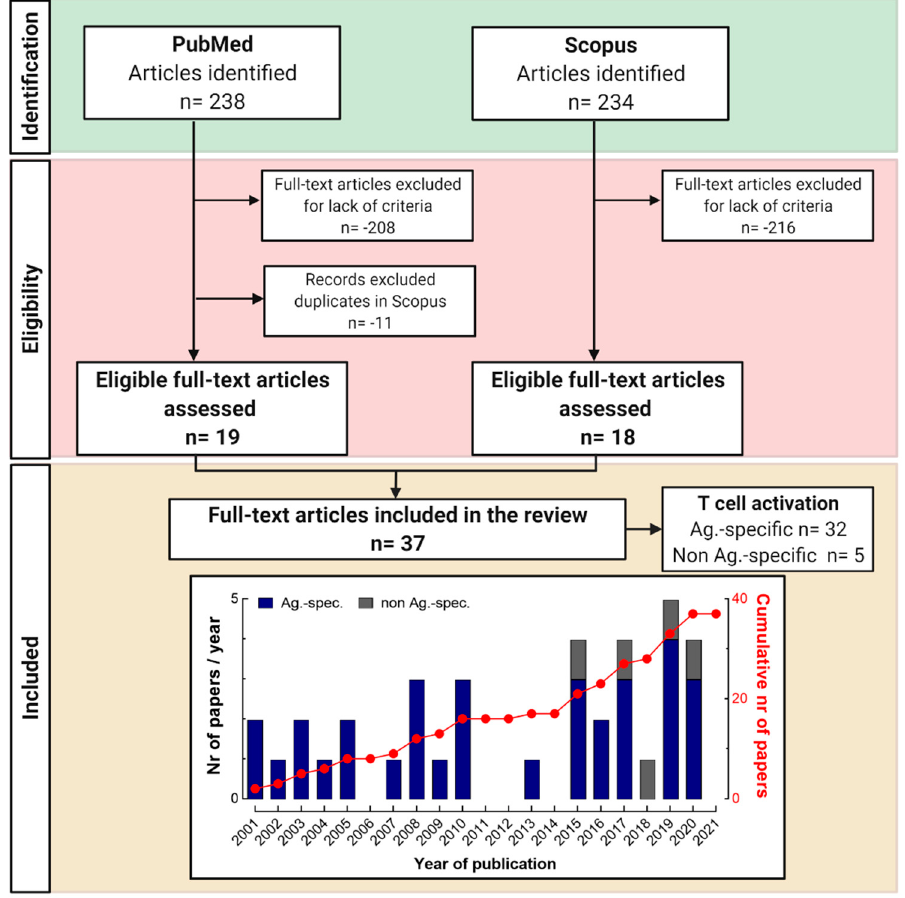
Figure 2. Flowchart of the search strategy applied in this systematic review according to the PRISMA statement 2020 guidelines [87]. The stacked bar histogram represents the time distribution of the articles included by year of publication (antigen (Ag.)-specific, blue, vs. non Ag.-specific, grey) and the red line the cumulative number of papers over the last 20 years (2001–2021).